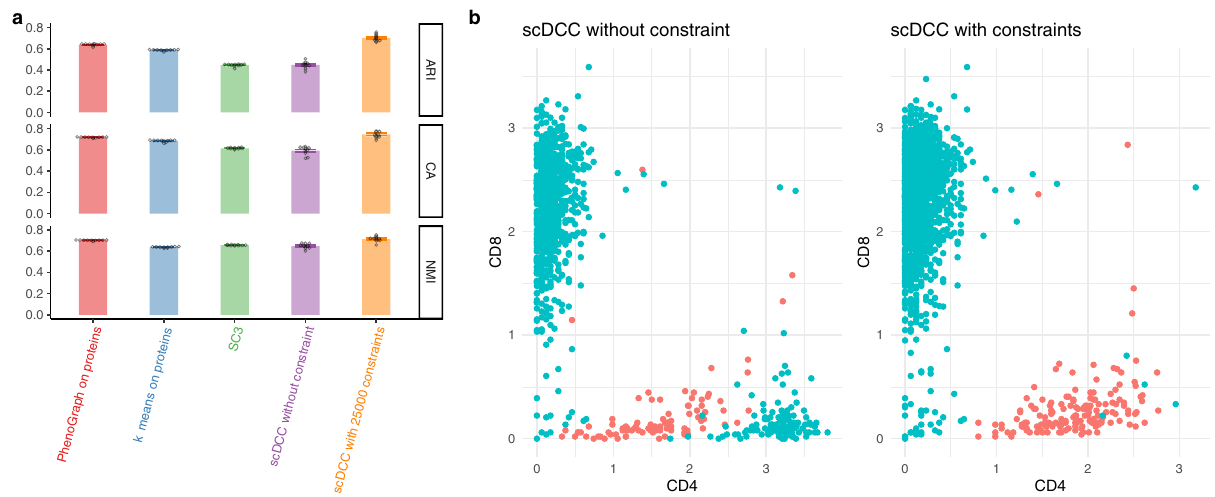
Fig. 5 Clustering analysis on the CITE-seq PBMC data with protein-based constraints. a Clustering performances of PhenoGraph and k-means on proteins, SC3, and scDCC (without and with constraints) on mRNAs of CITE-seq PBMC dataset, measured by NMI, CA, and ARI. All experiments are repeated ten times (one dot represents one experiment), and the means and standard errors are displayed. Constraints were generated from protein expression levels. b CD4 and CD8 protein expression levels in the identi fi ed CD4 and CD8 speci fi c cells. Colors (Cyan represents CD8 cells and red represents CD4 cells) are cluster labels identi fi ed by scDCC with and without constraints on proteins. Cell labels were annotated by differential expression